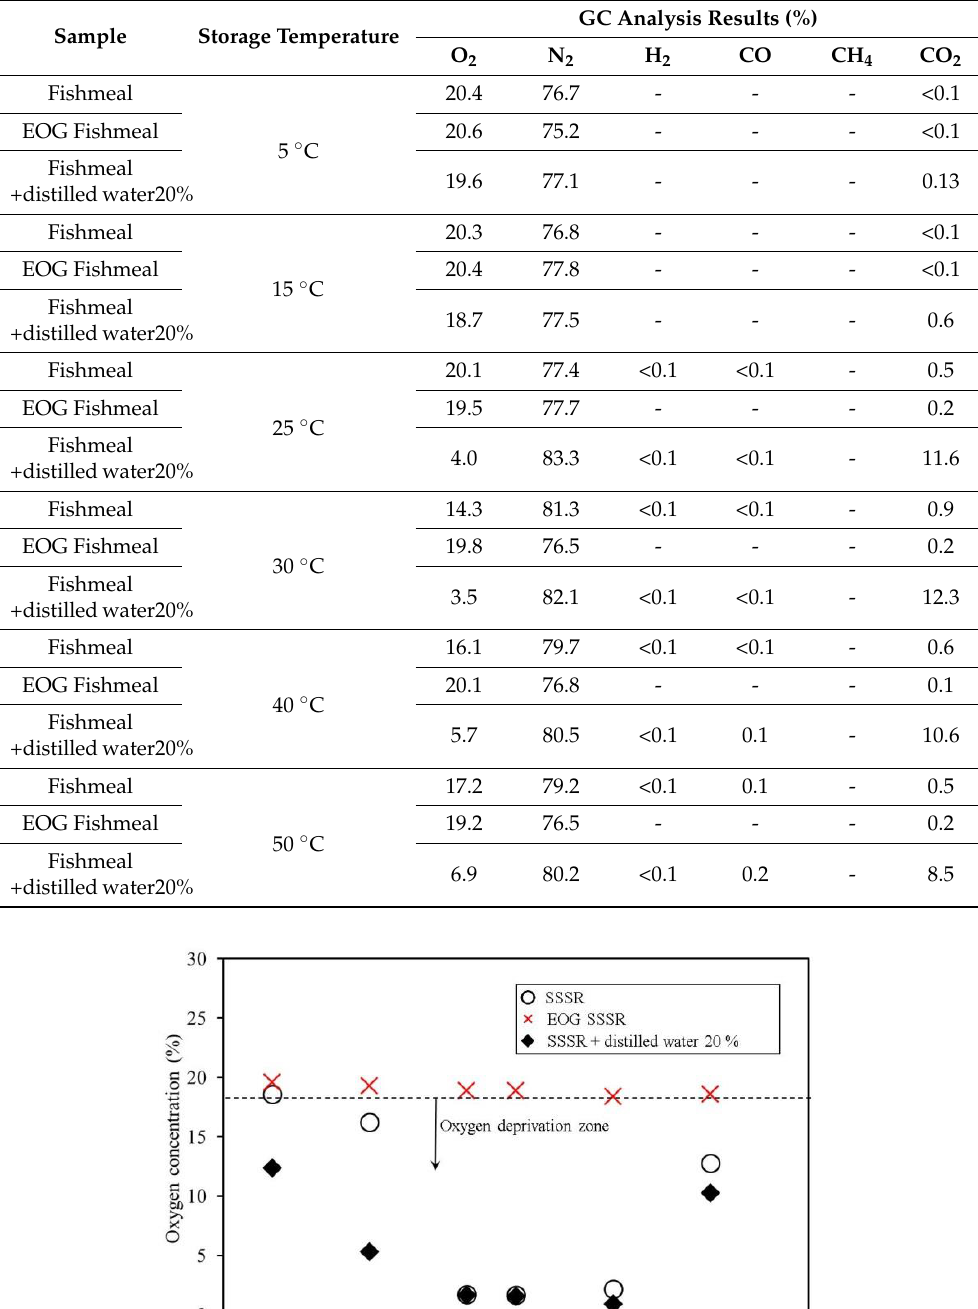
Table 9. GC data for fishmeal stored at various temperatures (5–50 ◦ C).